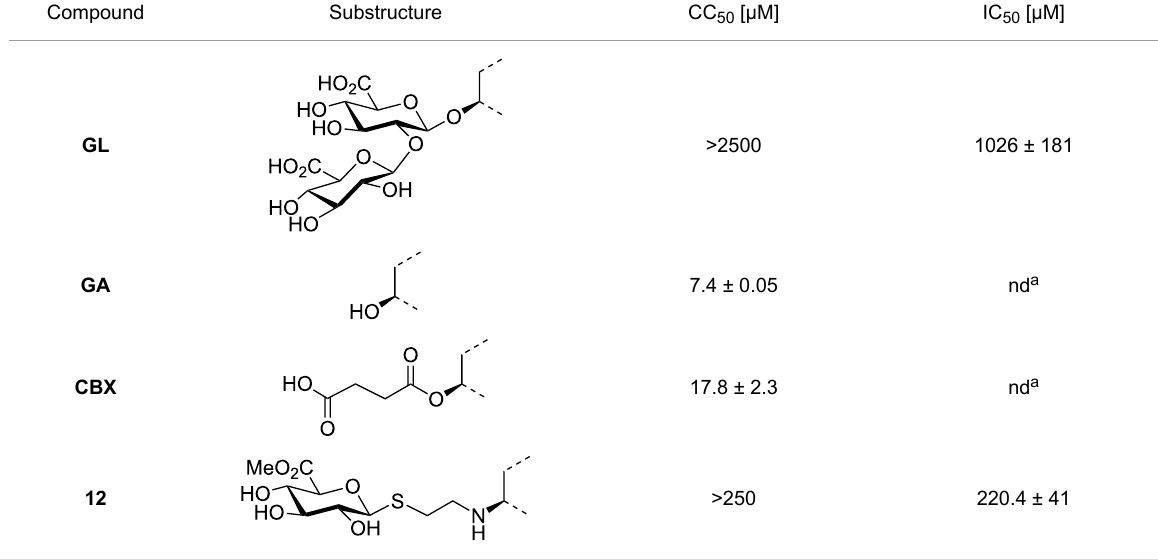
Table 1: Cytotoxic concentration 50% (CC 50 ) of compound-treated uninfected cells and antiviral activities, shown as half-maximal inhibitory concen- tration (IC 50 ) values of glycyrrhizin ( GL ) analogues.